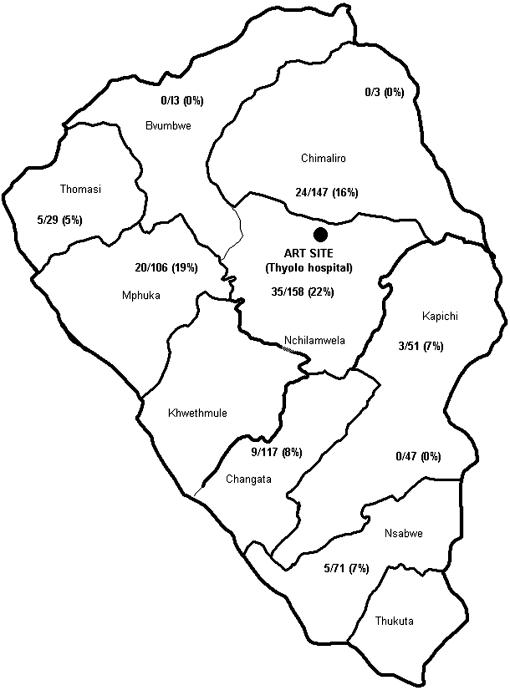
Geographic distribution of tuberculosis cases placed on ART.•ART delivery site, Thyolo hospital. Numbers and percentages (%) represent the proportion of HIV-positive TB patients placed on ART.